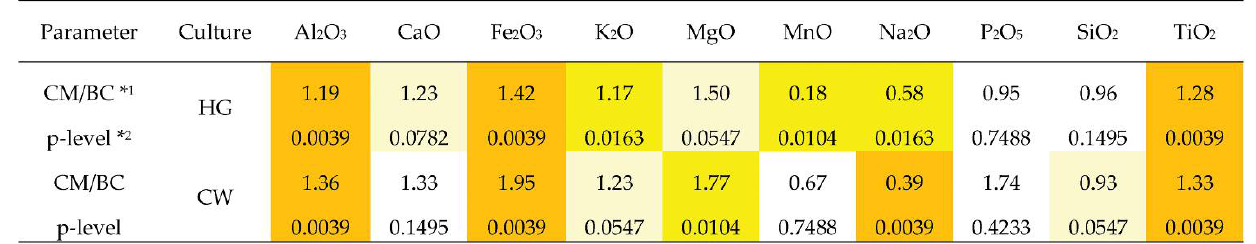
Figure 7. Elemental ratios values of median amounts between clay matrix and bulk compositions of hunter-gatherer pottery (HG) and Corded Ware (CW). * 1 Ratios values of median quantity of analytes in clay matrix (CM) and bulk composition (BC) of six pottery samples. Amounts in CM were used as the numerator, whereas that in BC was used as the denominator. * 2 p -values calculated using the Mann–Whitney U Test for the independent variables. Ratios values significant at p < 0.01 level are given in light brown, at 0.01 < p < 0.05 in yellow, at 0.05 < p < 0.1 in light yellow.